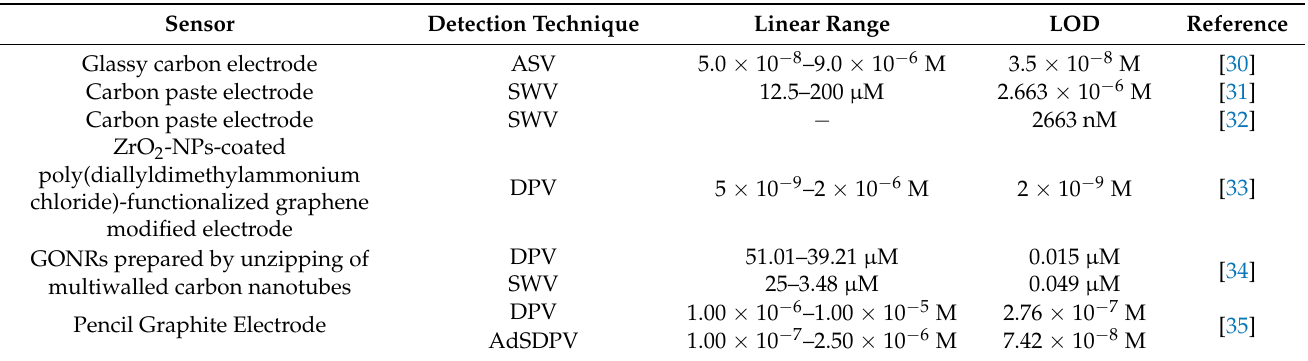
Table 1. The main voltammetric sensors used in diosmin